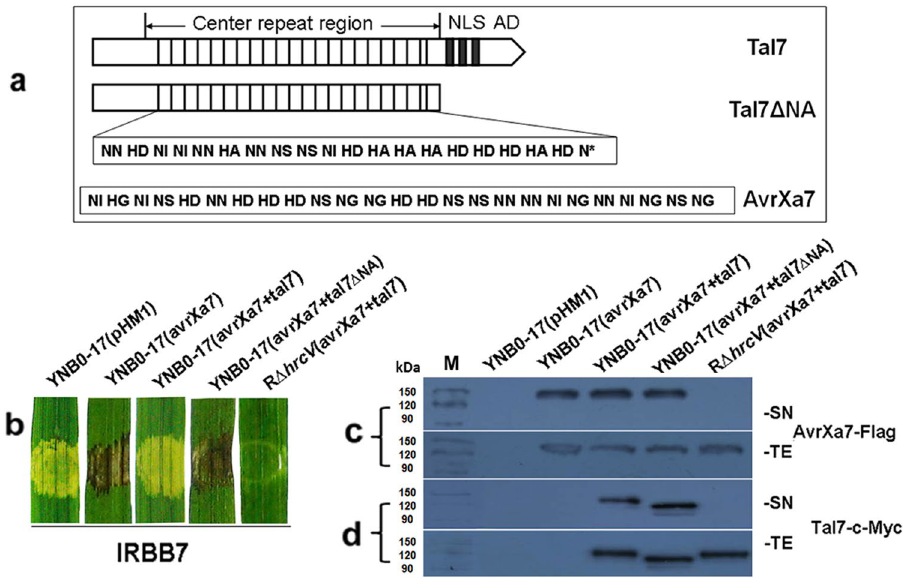
Figure 2. Tal7 suppresses avrXa7 - Xa7 mediated defense. ( a ) Diagram showing the RVDs of Tal7 and AvrXa7 and schematic construction of Tal7 ∆ NA. ( b ) Tal7 suppressesthe avrXa7 - Xa7 interaction in rice. Strain YNB0- 17 harboring pHM1, avrXa7 , avrXa7 + tal7 , and avrXa7 + tal7 ∆ NA were infiltrated into rice seedlings of IRBB7( Xa7 ) with needleless syringes. The T3SS-deficient strain of RS105, R ∆ hrcV (Supplemental Table S1), containing avrXa7 + tal7 , was used as a control. Leaves were scored for water-soaked symptoms or the HR at 3 dpi and were designated as susceptible or resistant, respectively. Leaves were photographed 3 dpi. ( c ) Secretion of AvrXa7-Flag and ( d ) Tal7-c-Myc by strain YNB0-17 harboring the constructs mentioned in panel b. Bacterial cells containing p707 or p707 Δ NA (Supplemental Table S1) were induced in XOM3 medium as described in Methods. Bacterial supernatants (SN) and total extracts (TE) were analyzed by SDS-PAGE, transferred to polyvinylidene difluoride membranes, and used for immunoblotting with anti-FLAG ( c ) or anti-C-Myc ( d ) as the primary antibody. The experiments were repeated three times, and similar results were obtained each